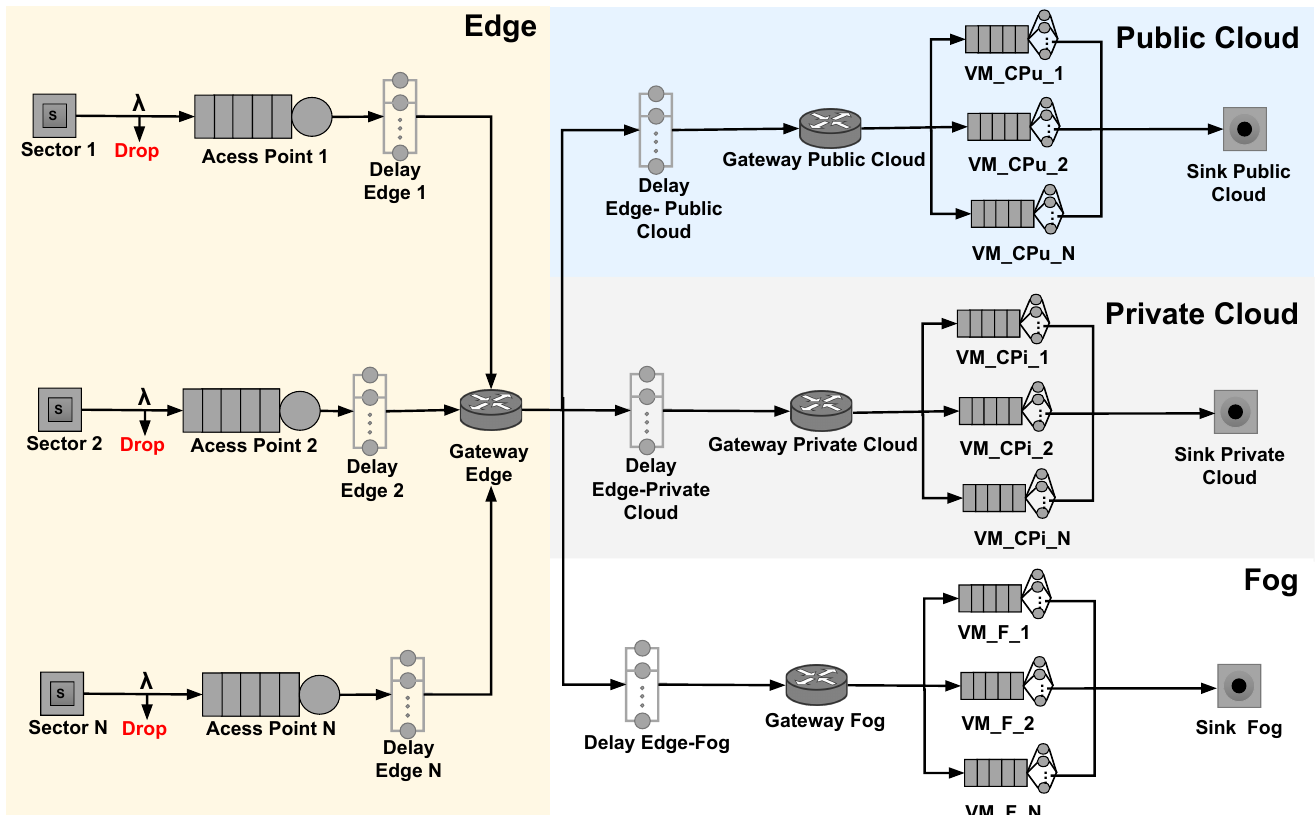
Figure 3. Overall queuing-network-based performance model of a typical IoRT computing